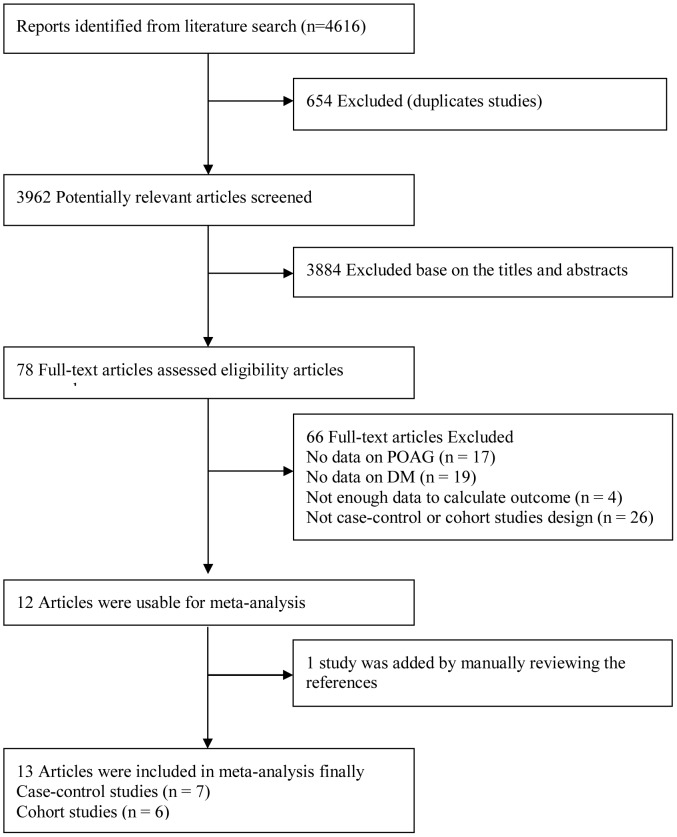
Flow diagram outlining the selection process for the inclusion of the studies in the systematic review and meta-analysis.POAG = primary open-angle glaucoma; DM = diabetes mellitus.